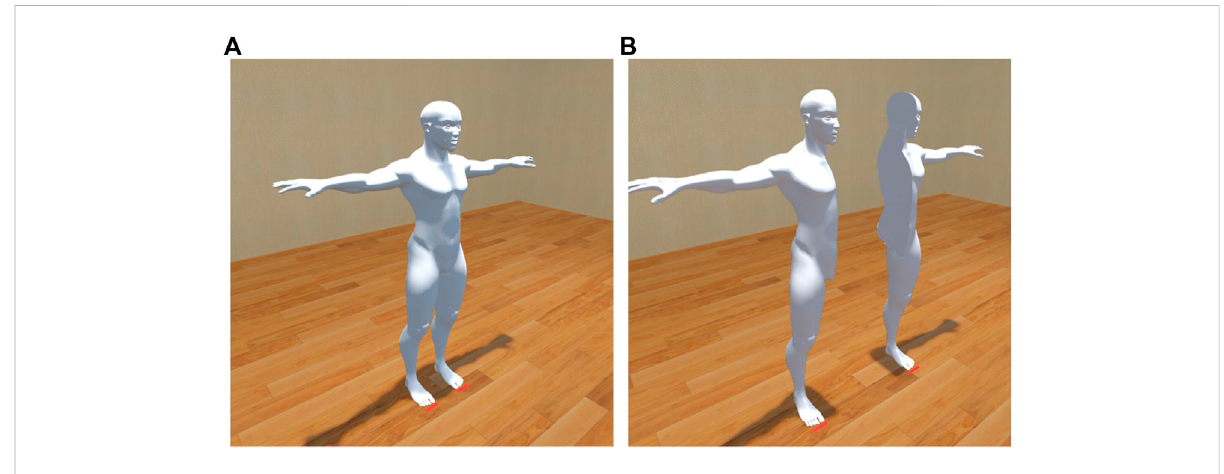
FIGURE 1 Normal avatar (A) and split avatar (B) .